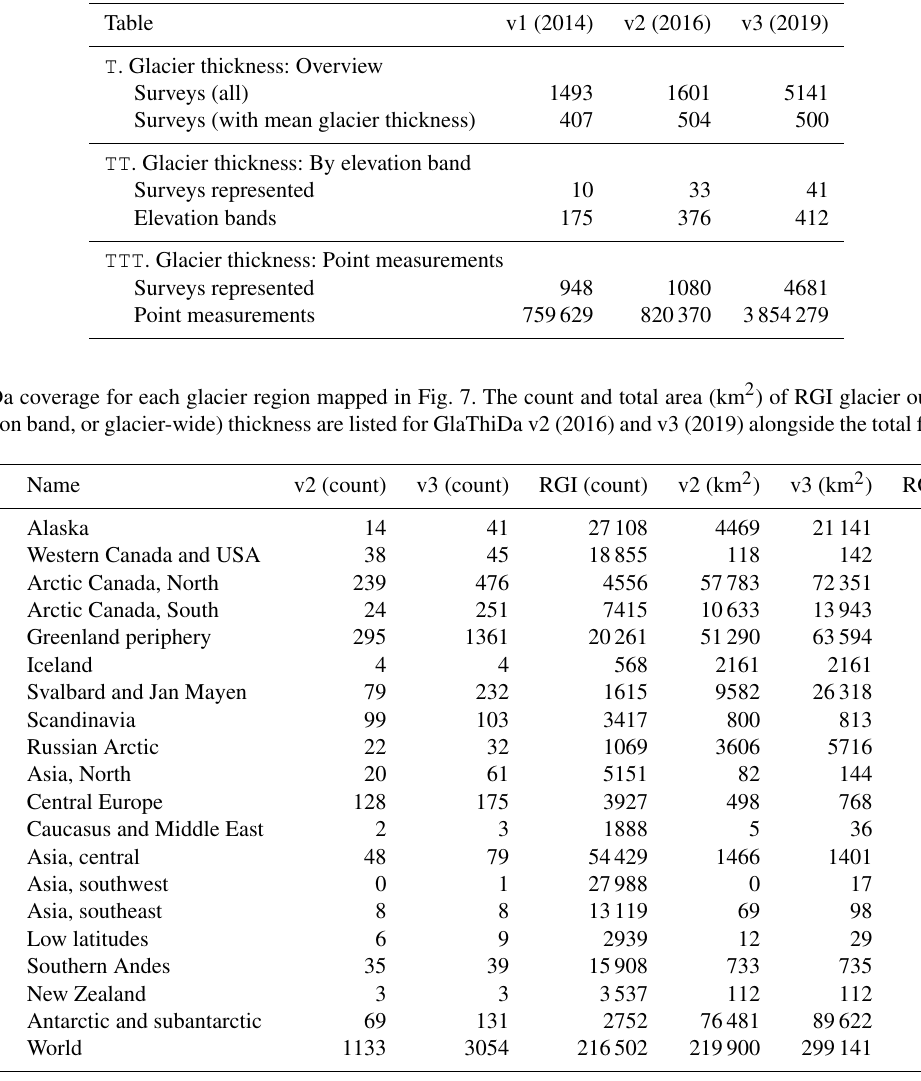
Table 2. Total number of rows (surveys, elevation bands, or point measurements) and number of surveys represented in each table, by GlaThiDa version (“v”, with the release year in parentheses). Since not all glacier surveys have a mean glacier thickness in table T , such surveys are counted separately.